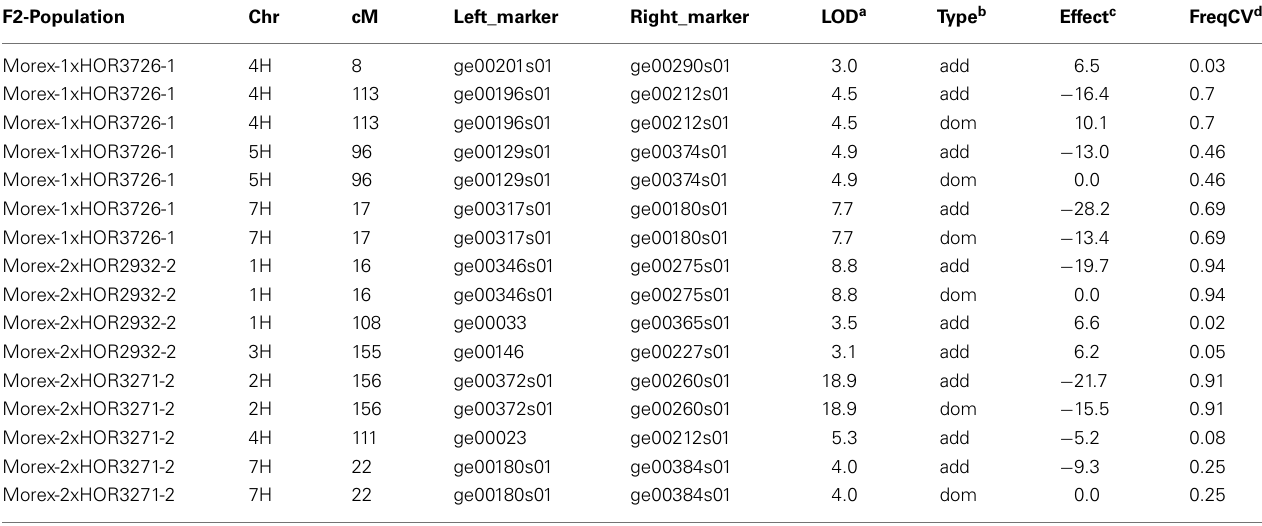
Table 2 | Mapping of resistance QTL against Bgh in three populations of resistant accessions x Morex. F2-Population